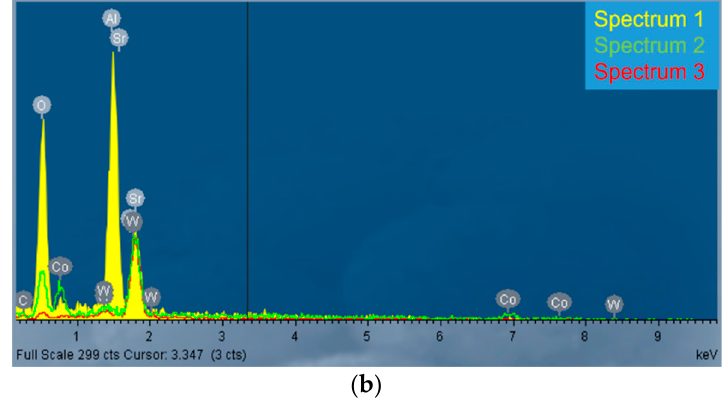
Figure 19. SEM micrograph ( a ) and EDS analysis ( b ) of WC-Co.